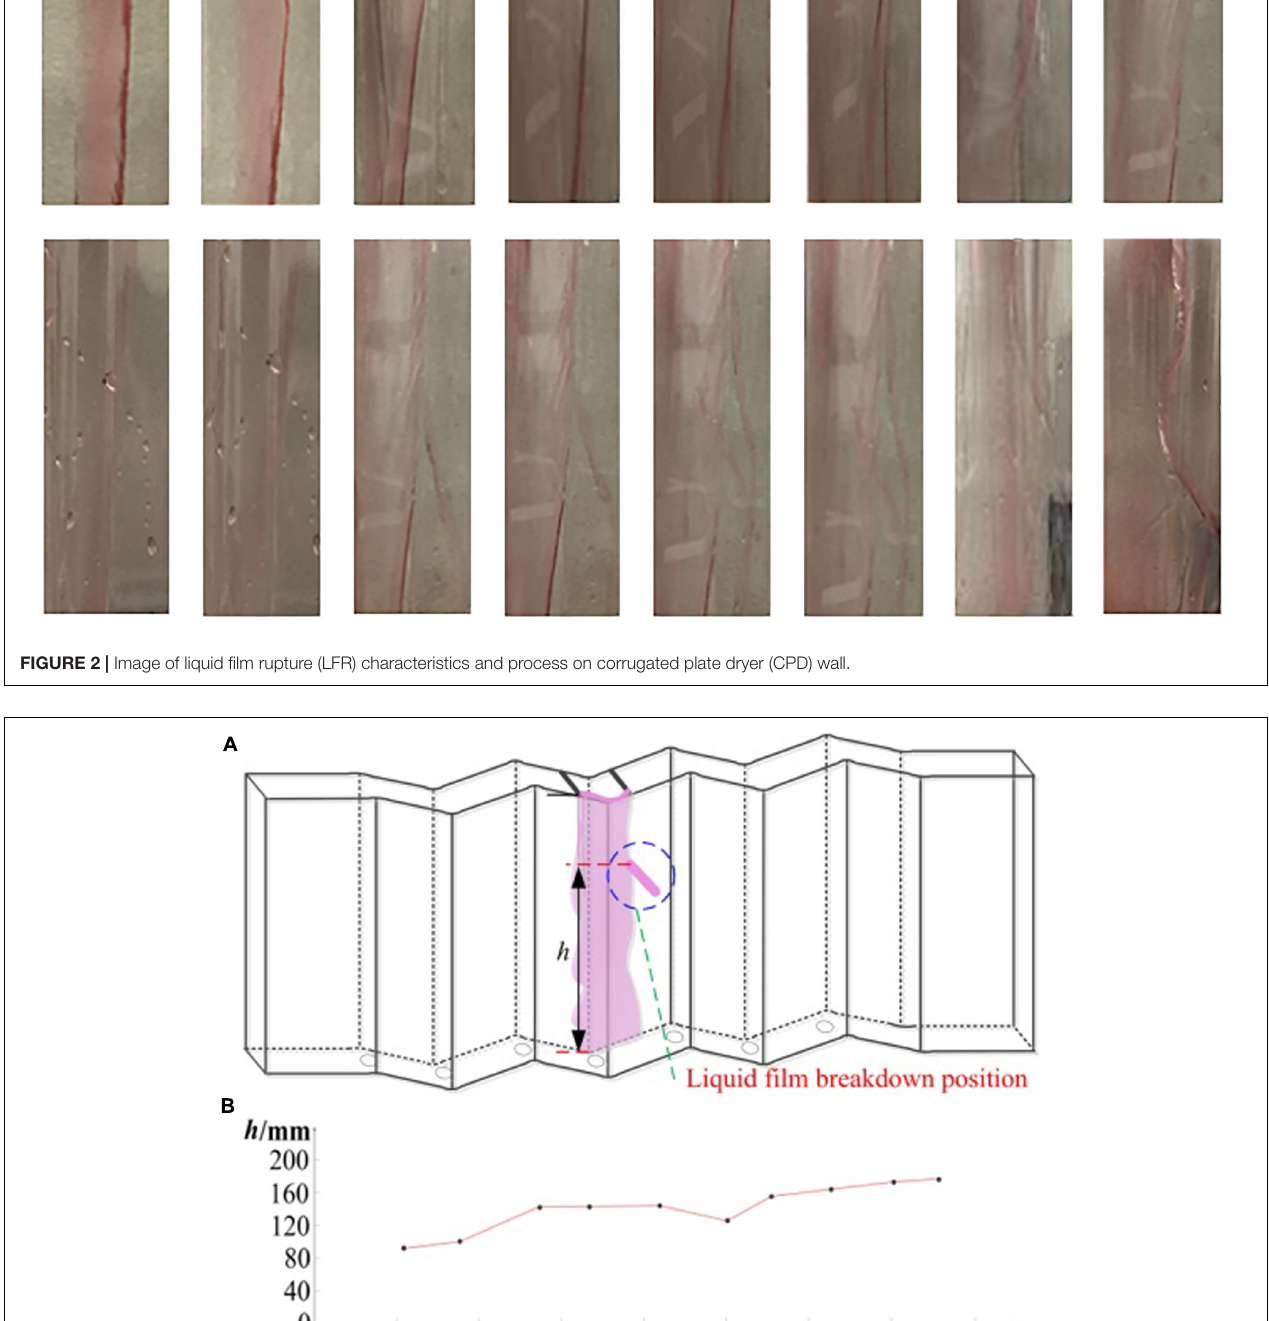
Frontiers in Energy Research |